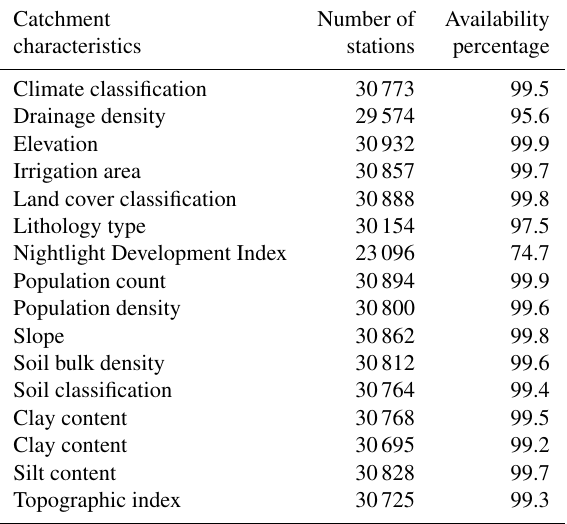
Table 8. Percentages of available catchment-scale characteristics.